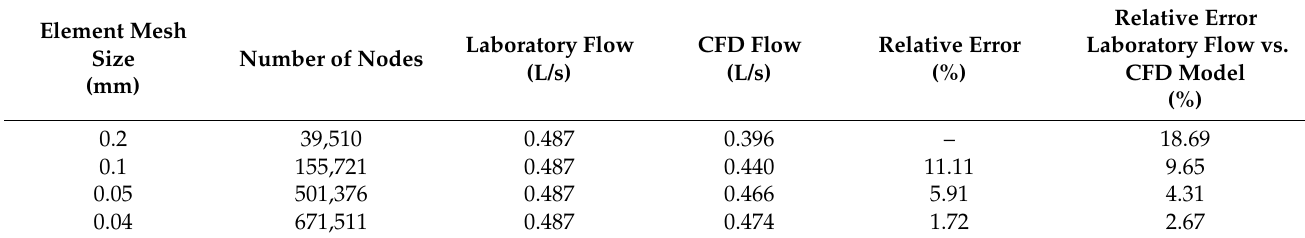
Table 6 . Mesh Convergence for the A5 Test Screen . Table 6. Mesh Convergence for the A5 Test Screen.